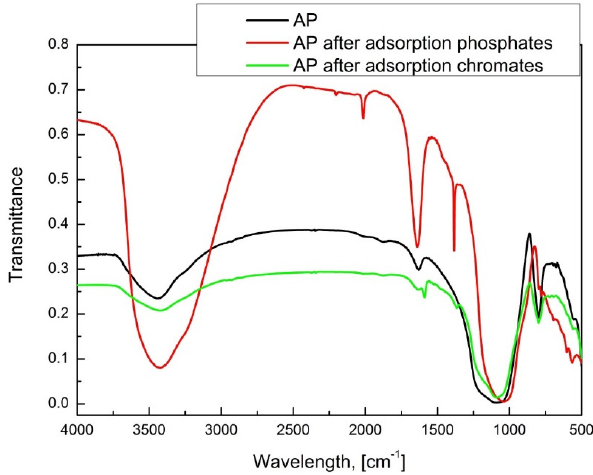
Figure 4. FTIR analysis of Absodan Plus samples.